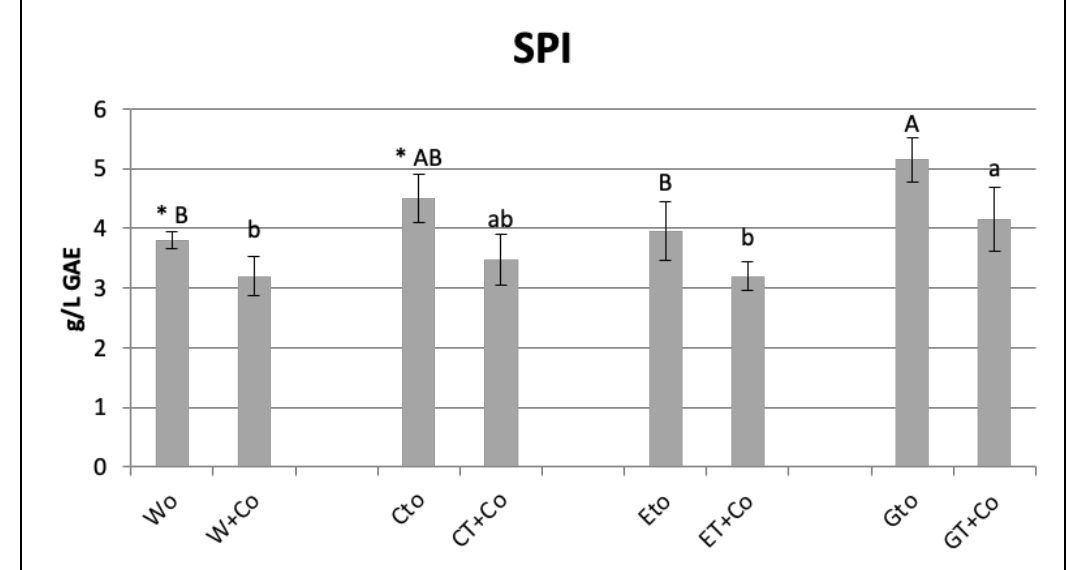
Figure 3. Oxidation effect on the SPI (saliva precipitation index) of the treated wines. Different letters indicate a statistically significant difference among treated wines according to Tukey’s (HSD) analysis ( p < 0.05). The effect of tannins addition is expressed with a capital letter on wines Wo, CTo, ETo, and GTo (A, B), and the effect of chitosan addition is expressed with a lowercase letter on wines W-Co, CT-Co, ET-Co, and GT-Co (a, b). The asterisk (*) indicates a statistical difference between each kind of wine before and after the treatment with chitosan. All data are expressed as means ± standard deviation.